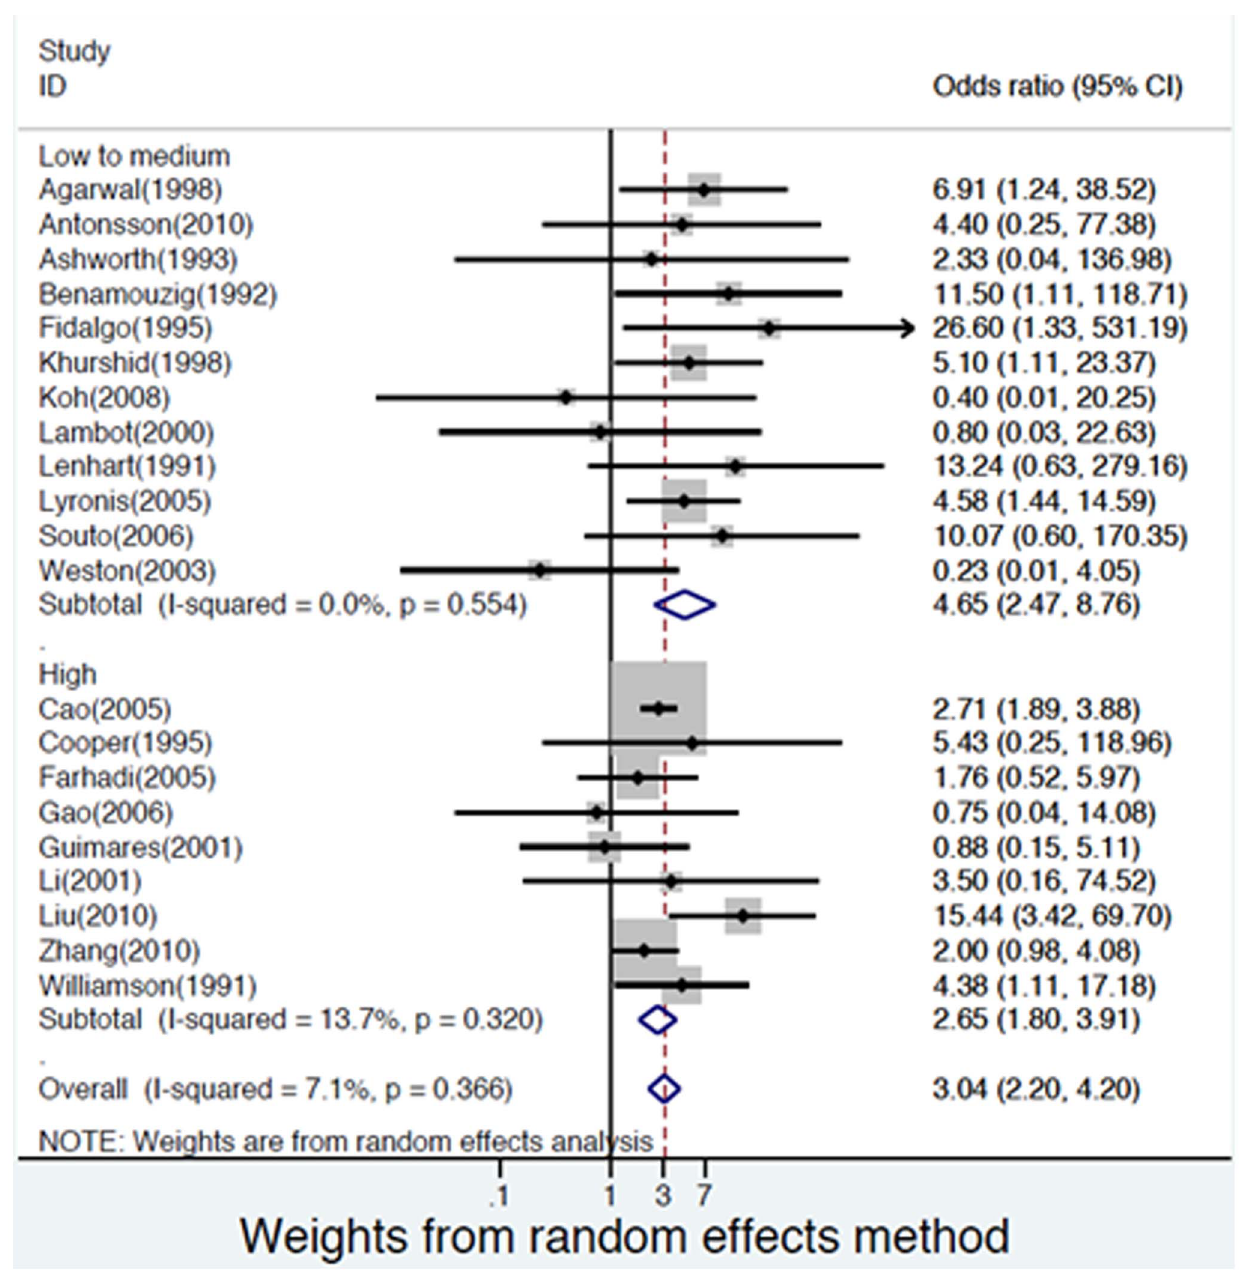
Figure 6. Forest plot and meta-analysis by region of OSCC risk level.